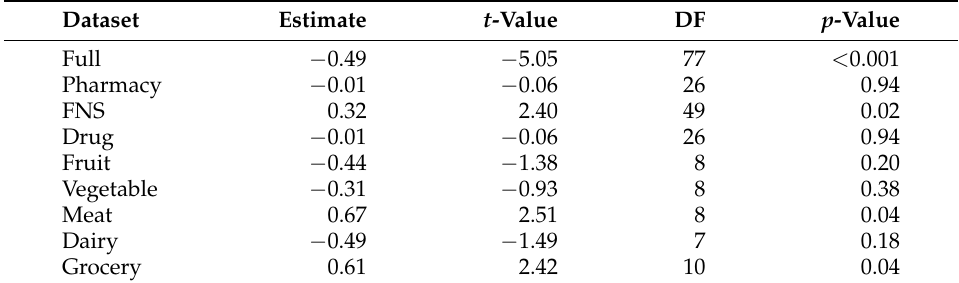
Table 6. Pearson product-moment correlation of saving of inventory cost (in %) versus MCDM RoCo SFSCM score (expressed as a proportion between zero and